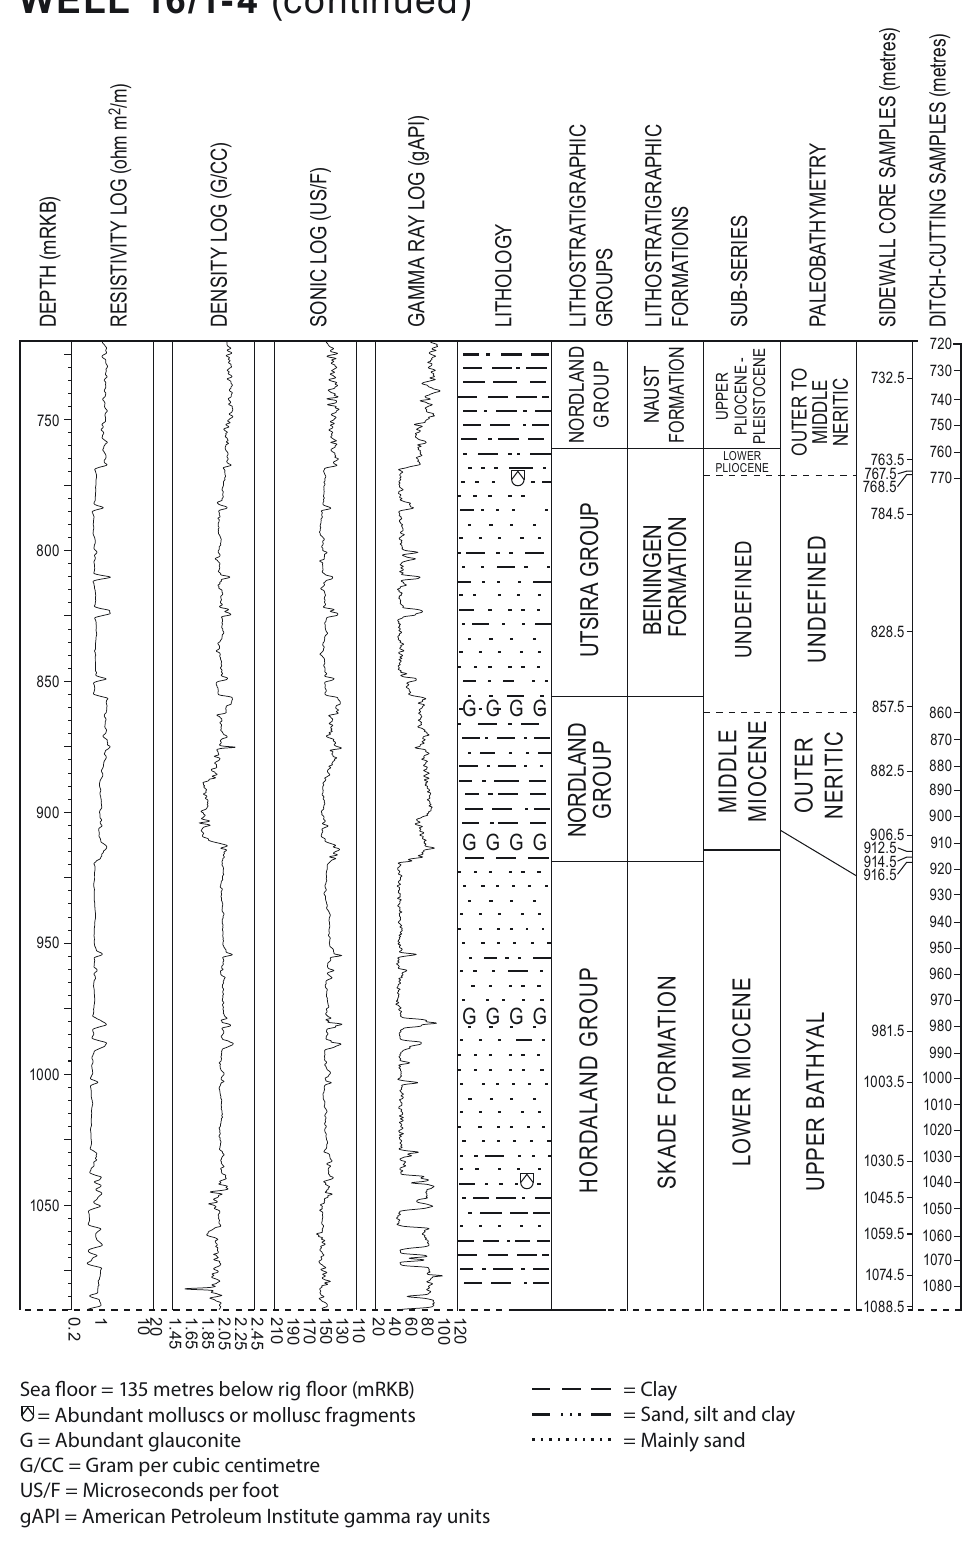
Figure 46. Well summary figure including resistivity log, density log, sonic log, gamma-ray log, lithology, litho- stratigraphic units, sub-series, paleobathymetry and analysed samples for the upper part of the investigated sequence in well 16/1–4 (lower Miocene to upper Pliocene/Pleistocene) including the supplementary well reference section for the Skade Formation (upper part; modified after Eidvin et al.,